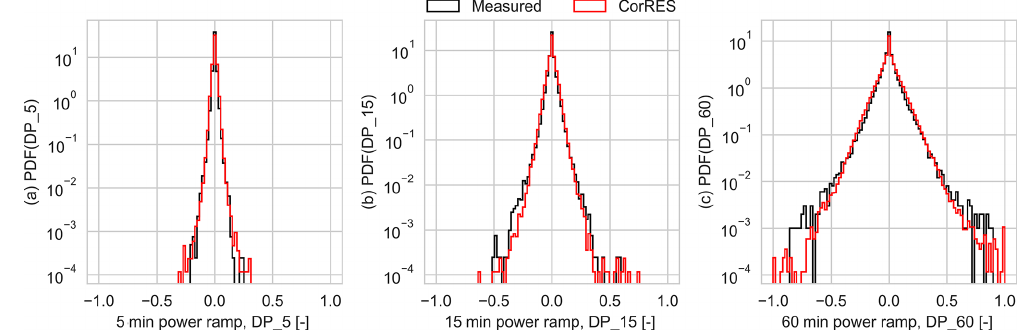
Figure 10. Distributions of standardized power fluctuations in different windows: (a) 5min (DP_5), (b) 15min (DP_15), and (c) 1h